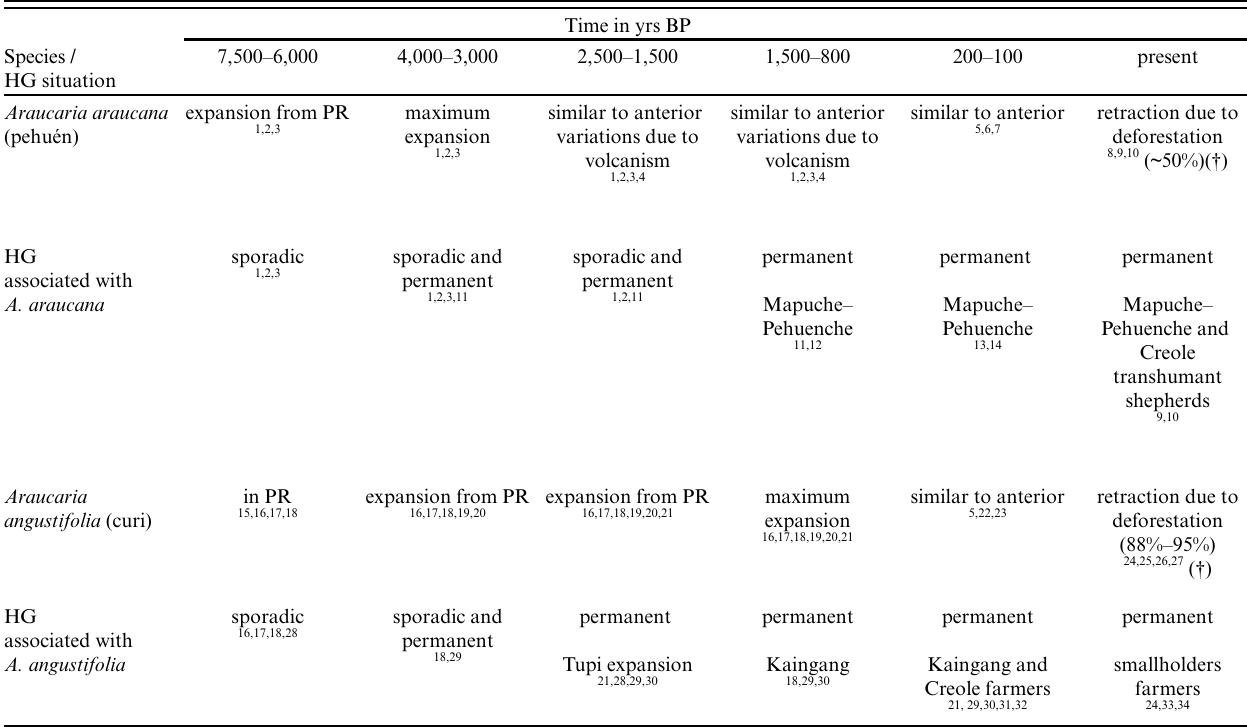
Table 1. Evidence of the development over time of the distribution ranges of South American Araucaria from Pleistocene refugia (PR) and their relationship with the presence of human groups (HG) from the Holocene